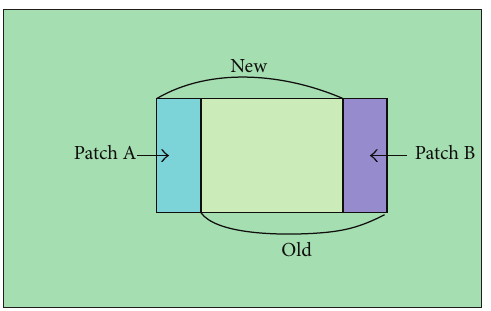
Figure 7: The slide of matching